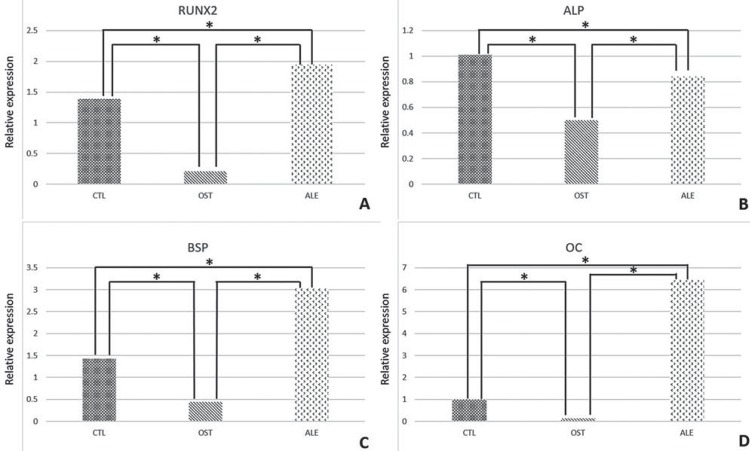
A- RUNX 2. (*) p<0.05. B: ALP. (*) p<0.05. C: BSP. (*) p<0.05. D: OC. p<0.05 (*)